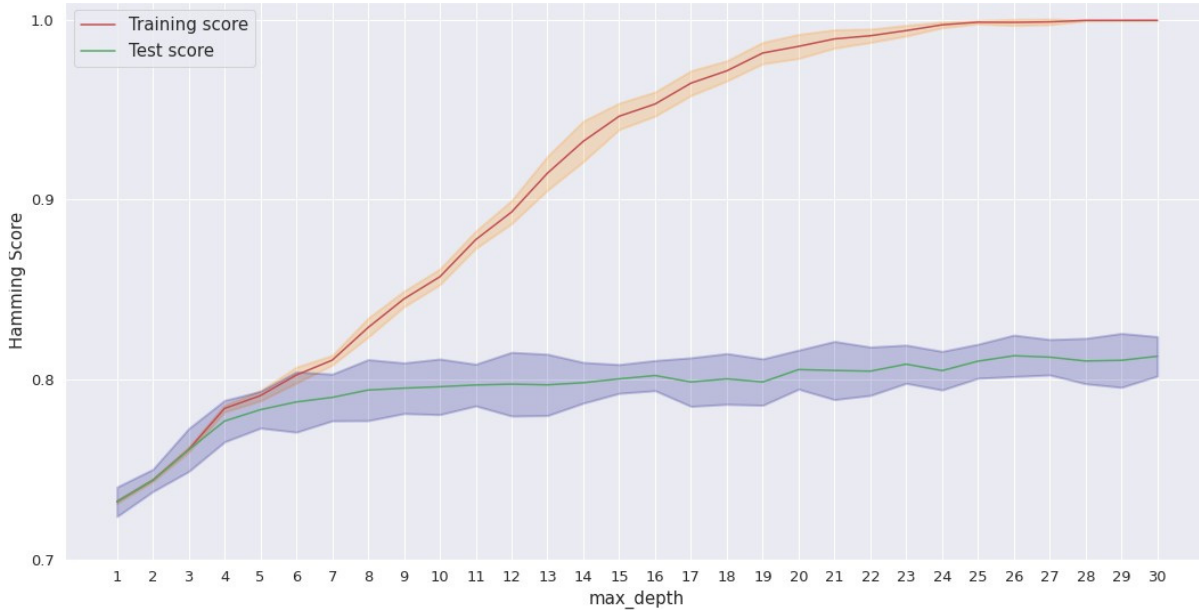
Figure 6. Validation curve for decision tree classifier.